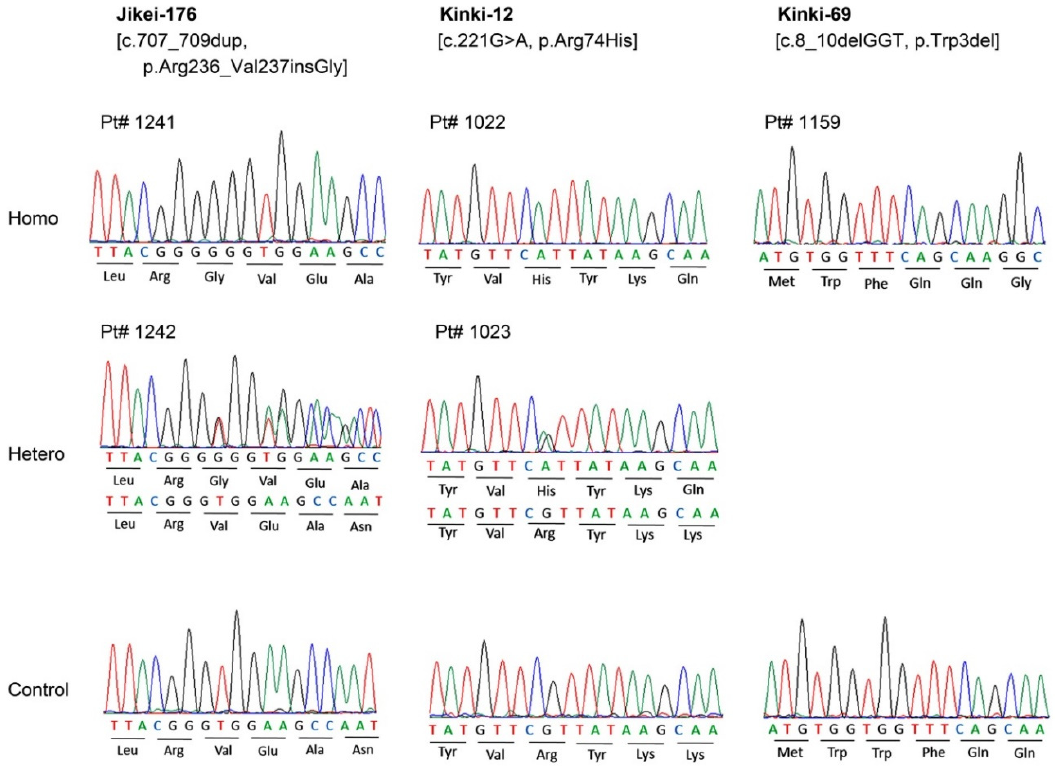
Figure 1. Results of Sanger sequencing; sequence chromatograms of identified DRAM2 variants.